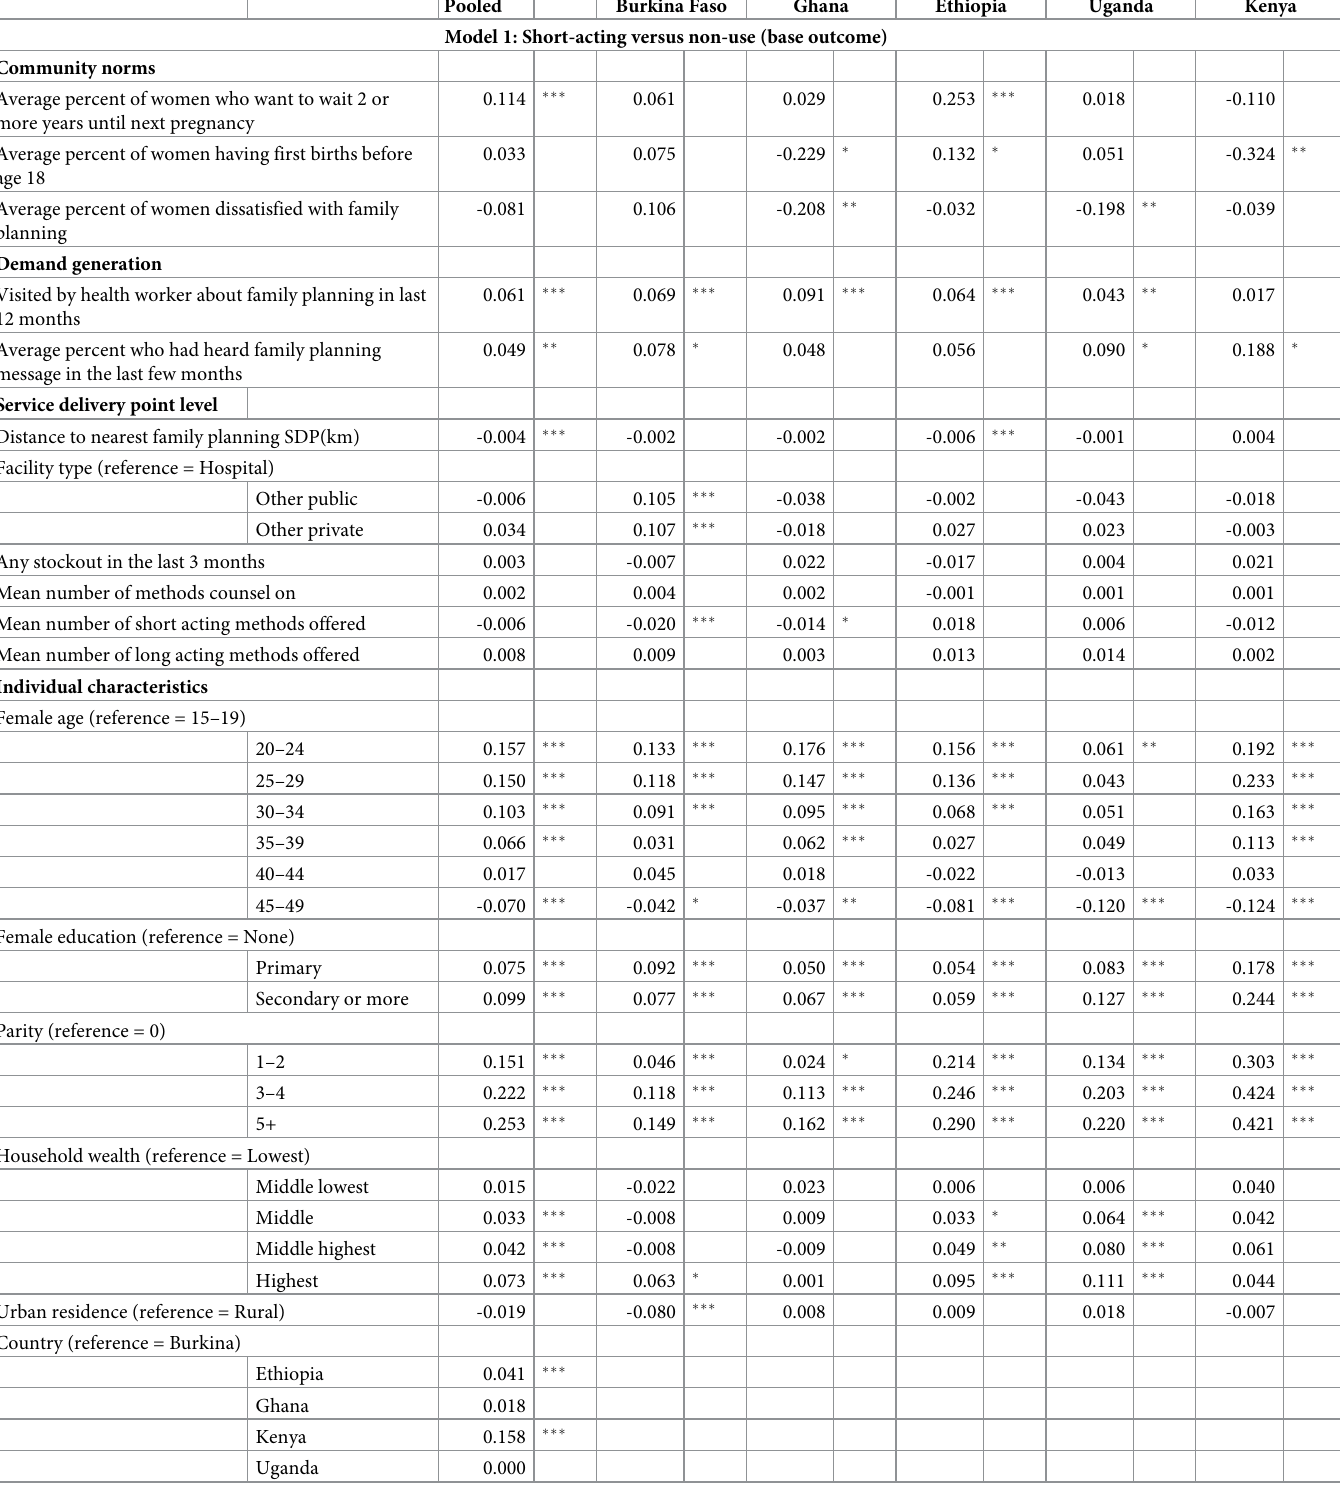
Table 3. Average marginal effects from the multilevel multinomial logistic regression model of individual women’s probability of short-acting contraceptive use on community, demand generation, and service delivery point variables adjusted for individual level socioeconomic characteristics, by country. Pooled Burkina